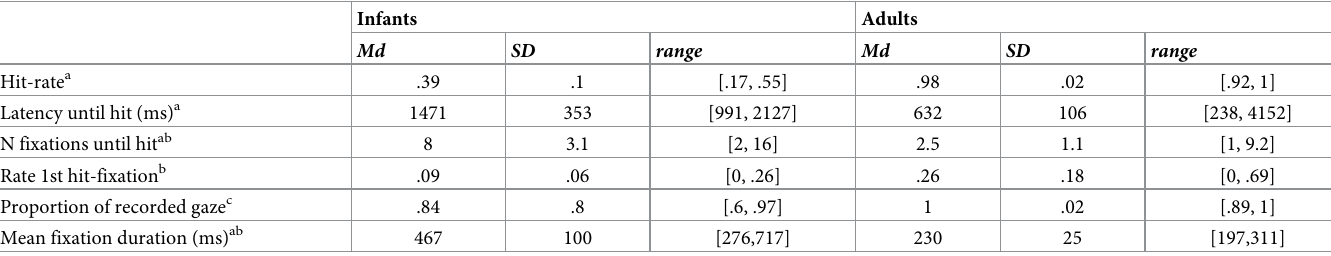
Table 2. Gaze and performance characteristics of infants and